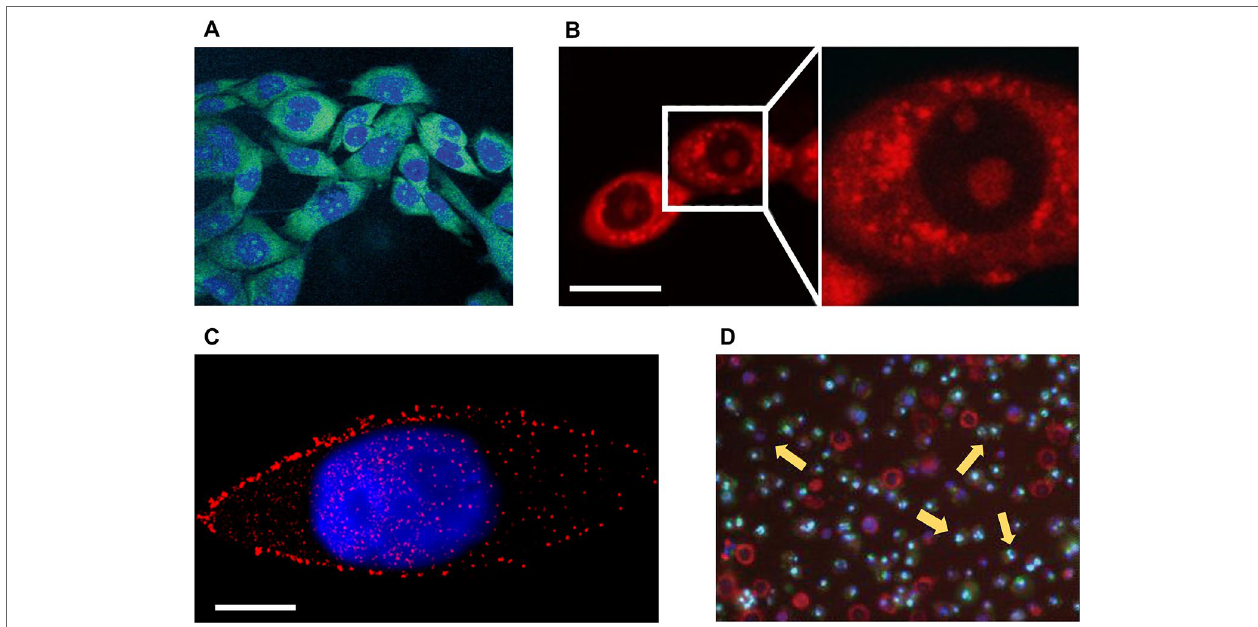
FIGURe 1 | Microscopic imaging of natural products in cell experiments. (A) The green fluorescent 12-aza-epothilone (azathilone) derivative localization in the cytoplasm, the blue area indicates the fluorescence imaging result of nucleus. Adapted with permission from Ref. Gertsch et al., 2009. (B) Confocal laser scanning microscopy detects mitochondria fission and swelling. Scale bar: 20 μm. Adapted with permission from Ref. Li et al., 2015. (C) Direct stochastic optical reconstruction microscopy imaging mTOR (red) and cell nucleus (blue). Scale bar: 10 μm. Adapted with permission from Ref. Teng et al., 2017. (D) Apoptosis assay of cells treated with apigenin by flow cytometry, yellow arrows indicate apoptotic cells. Adapted with permission from Ref. Cao et al., 2013.